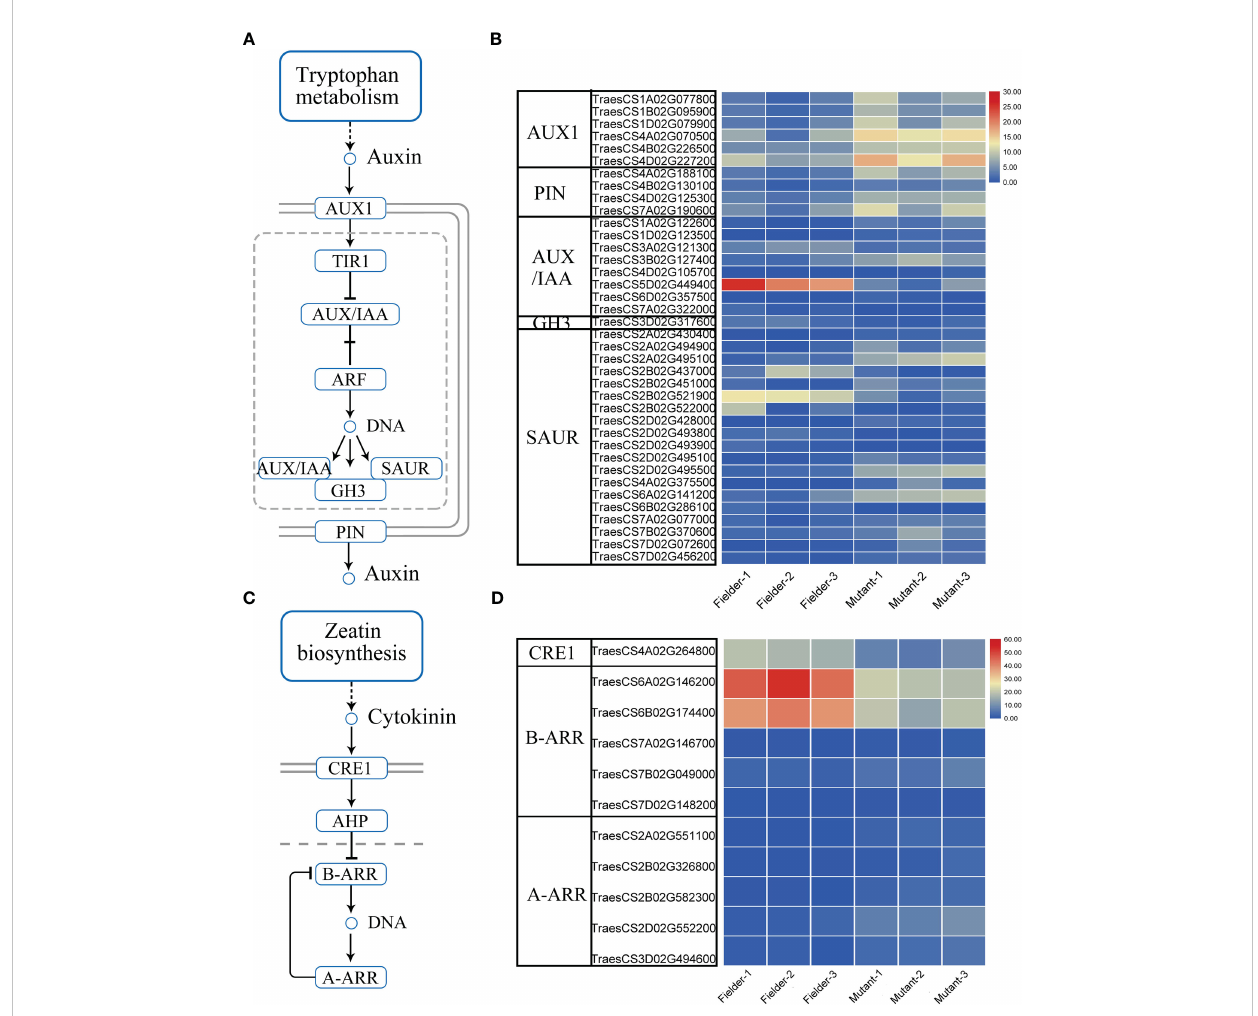
FIGURE 6 Auxin and cytokinin signaling pathways and the DEGs in these signaling pathways. (A) Identi fi ed auxin signaling pathway in plant. (B) Heat map displaying the relative expression levels of the key auxin signaling-related genes in the DEGs. (C) Identi fi ed cytokinin signaling pathway in plant. (D) Heat map displaying the relative expression levels of the key cytokinin signaling-related genes in the